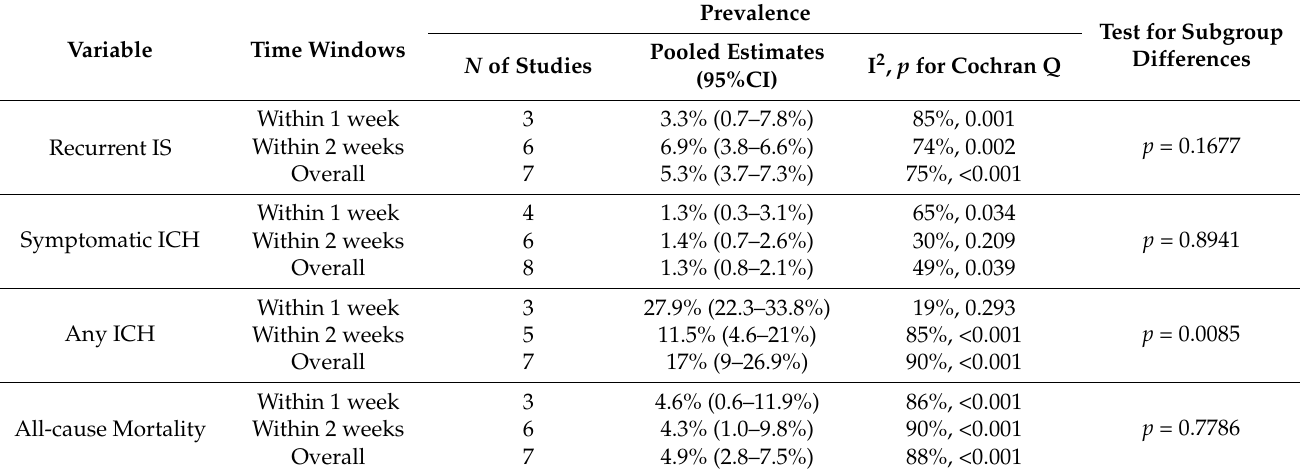
Table 2. Overview of the primary outcomes of the single-arm analysis according to the different time windows of initiating oral anticoagulants.